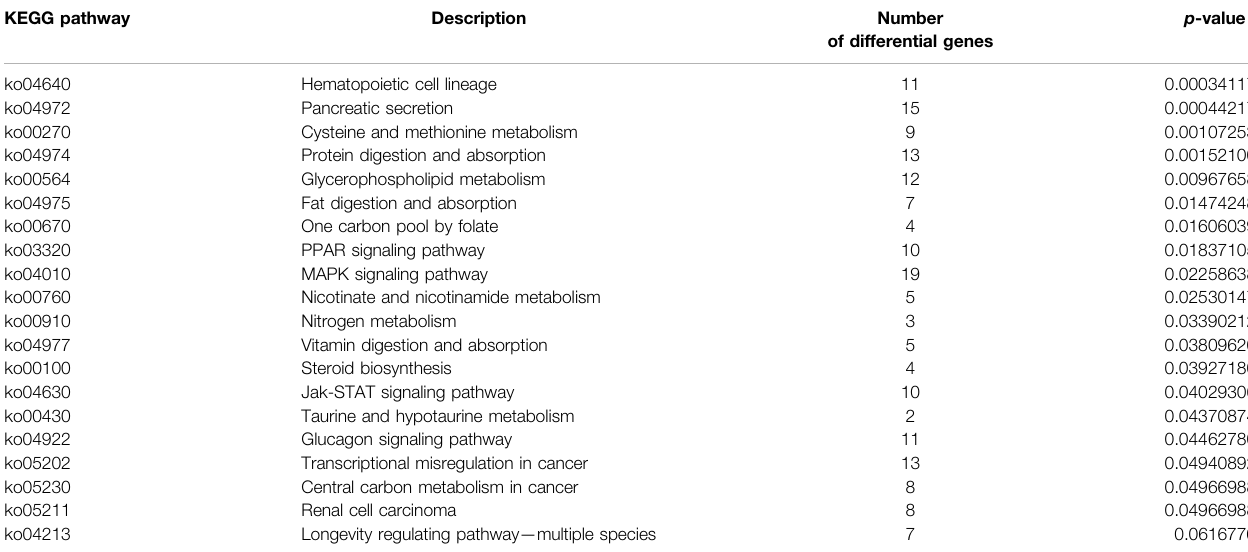
TABLE 5 | KEGG analysis of DEGs obtained by transcriptome sequencing. KEGG